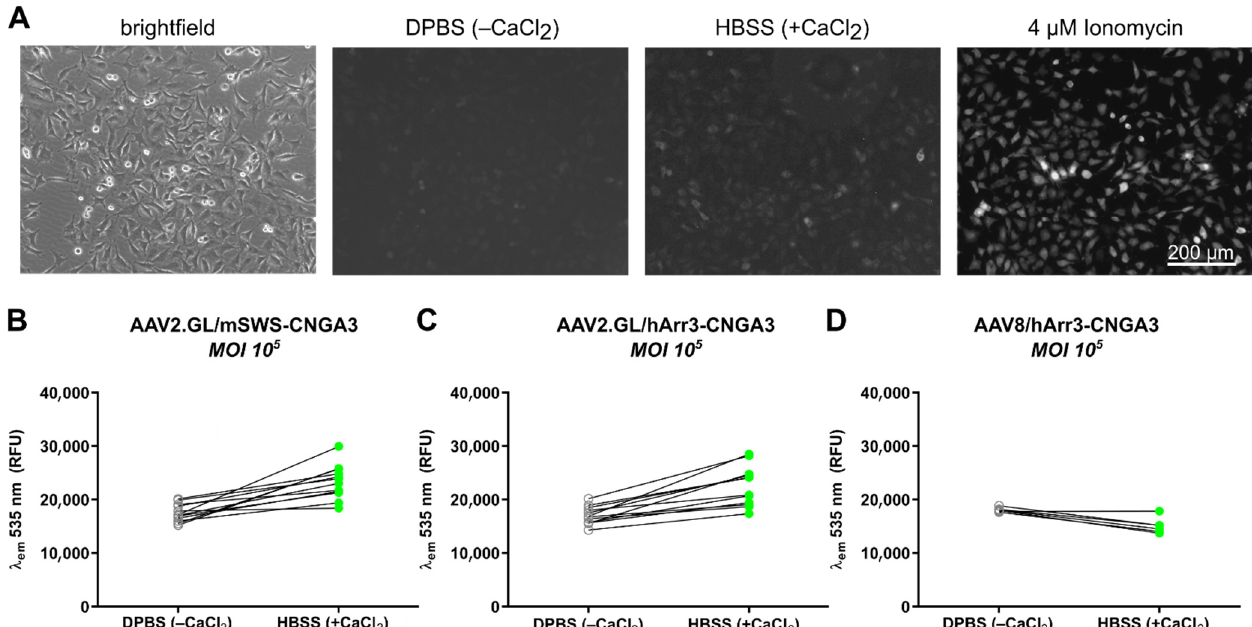
Figure 4. Discrimination of vector potencies using the optimal engineered HeLa cells expressing RhGC-GCaMP6s. ( A ) Representative fluorescence images of GCaMP6s signal after transduction with AAV2.GL/hArr3-CNGA3 in three conditions: in the absence of extracellular Ca 2+ (DPBS − CaCl 2 ), in high extracellular Ca 2+ (HBSS +CaCl 2 ), and positive control signal where cells are permeabilized with a 4 µ M ionomycin solution. ( B ) Quantification of relative fluorescence units (RFU) at λ em 535 nm cells transduced with AAV2.GL/mSWS-CNGA3 in the absence of extracellular Ca 2+ (DPBS − CaCl 2 ) versus high extracellular Ca 2+ (HBSS +CaCl 2 ). ( C , D ) As in ( B ) for cells transduced with AAV2.GL/hArr3- CNGA3 and AAV8/hArr3-CNGA3, respectively.